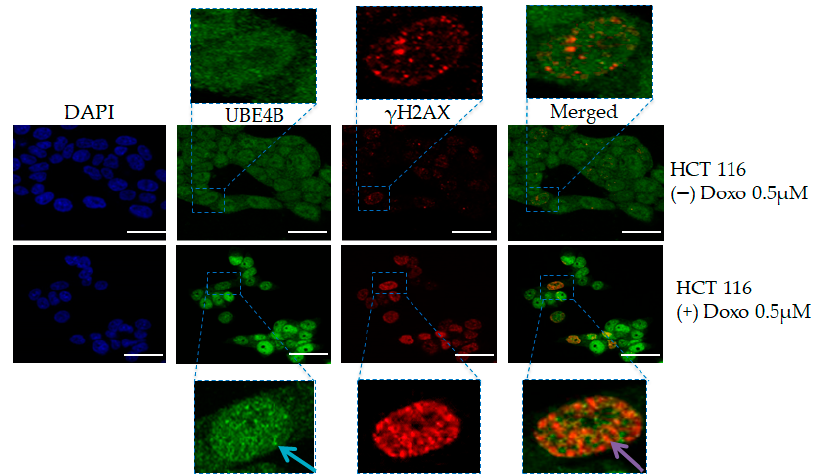
Figure 1. Foci UBE4B formation following DNA damage. UBE4B foci accumulate in the nucleus (blue arrow) compared to untreated cells (diffuse pattern) in HCT116 cells treated with 0.5 μΜ